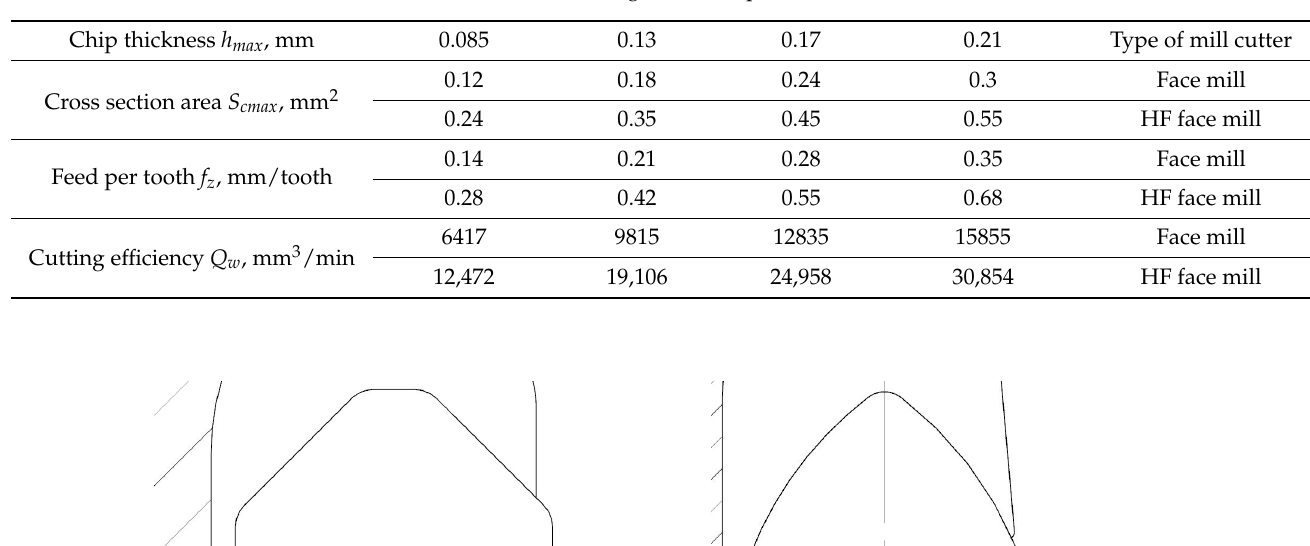
Table 1. The range of tested parameters.